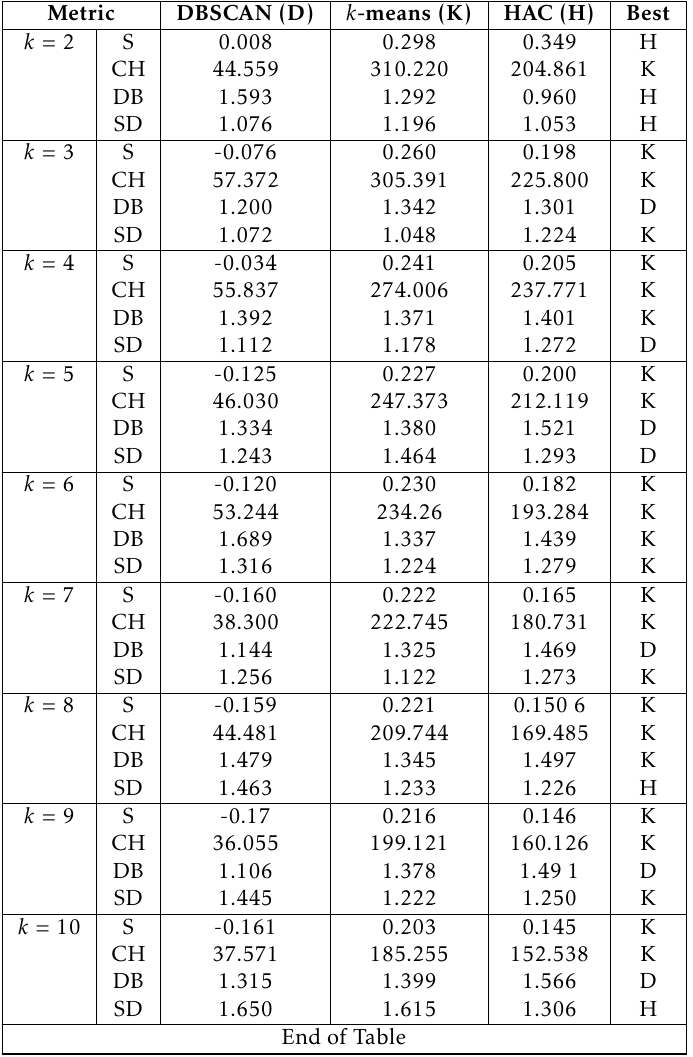
Table C.3. Performance of user clustering (Dataset NI ).